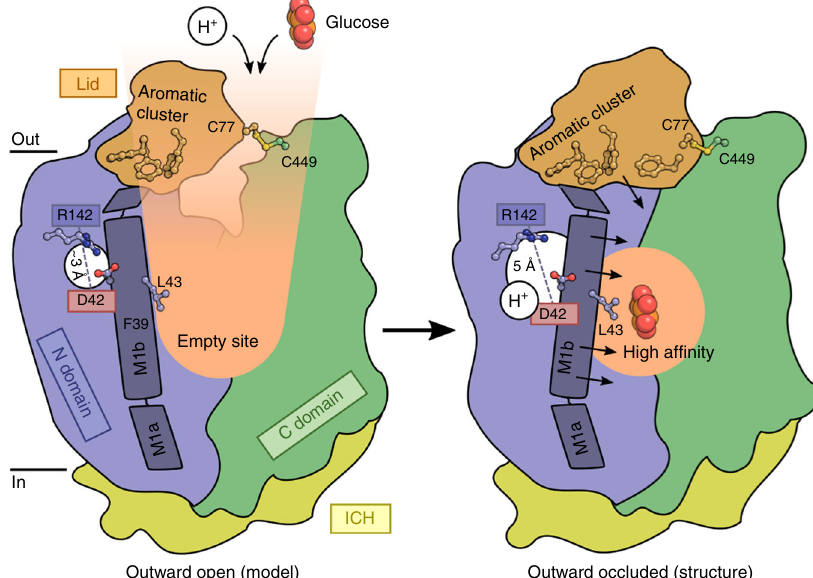
Fig. 4 Proposed mechanism of glucose coupling to proton donor/acceptor site. In the outward open conformation (left), protons and glucose enter the central binding sites through small rearrangements of the N domain and the Lid domain that is covalently linked to the C domain through Cys77-Cys449. Protonation of Asp42 leads to its repulsion away from Arg142 and pushes the fl exible M1b towards the glucose binding site, giving preference to high af fi nity glucose binding through Phe39 and Leu43 (right, observed structure). The aromatic cluster of the lid helps to isolate the proton donor/acceptor pair and maintain pKa values of Asp42 conductive to transport at a broad range of pH